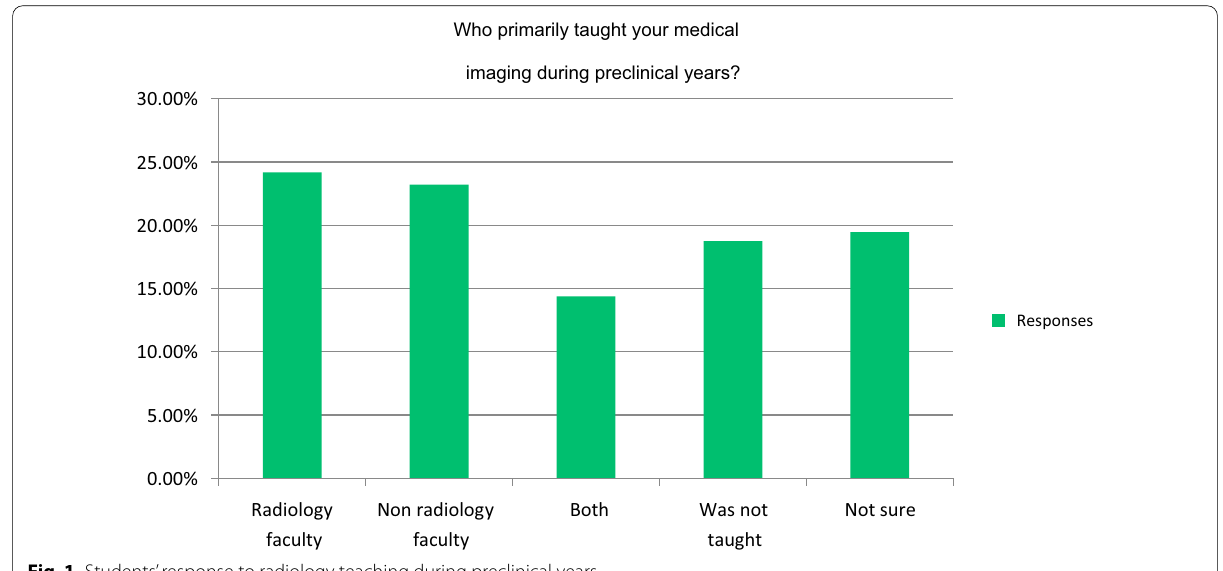
Fig. 1 Students’ response to radiology teaching during preclinical